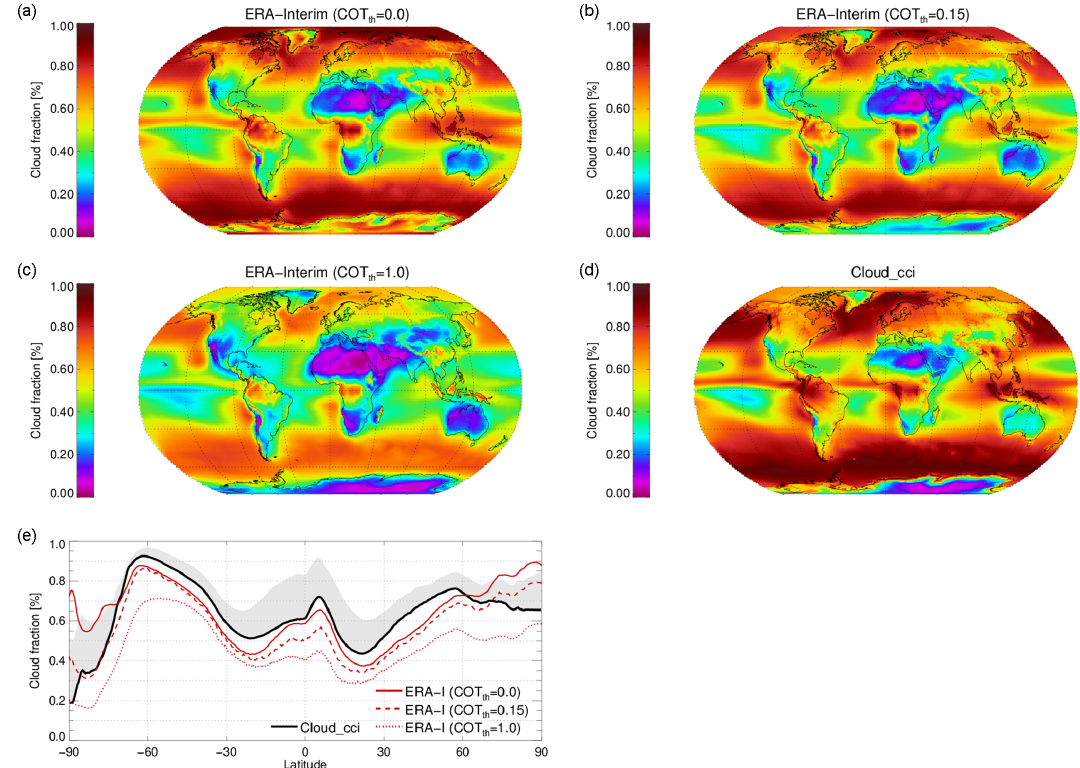
Figure 3. Multi-annual mean cloud fraction (CFC) from ERA-Interim (a–c) and Cloud_cci (d) , where the ERA-Interim cloud fraction was produced by SIMFERA for three optical thickness thresholds (COT th = 0 . 0, 0.15, 1.0). Panel (e) is the zonal mean plot of CFC for all four sets. The grey shaded area corresponds to the estimated systematic uncertainty in Cloud_cci CFC based on comparisons to CALIOP. The uncertainty in Cloud_cci is mainly due to missing optically very thin